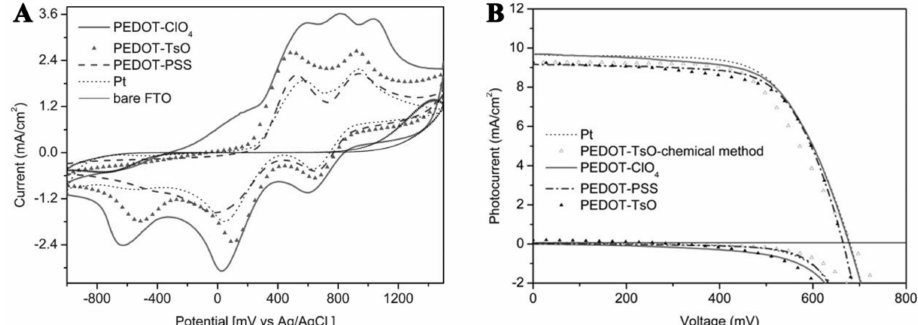
Figure 5. ( A ) cyclic voltammetry of an iodide/iodine-based electrolyte at different working electrodes, including PEDOT coated FTO, Pt, and bare FTO; ( B ) Comparison between current density-voltage (JV) curves of the DSSCs solar cells fabricated with different PEDOT counter electrodes and with the reference material Pt. Readapted with permission of Royal Society of Chemistry from reference